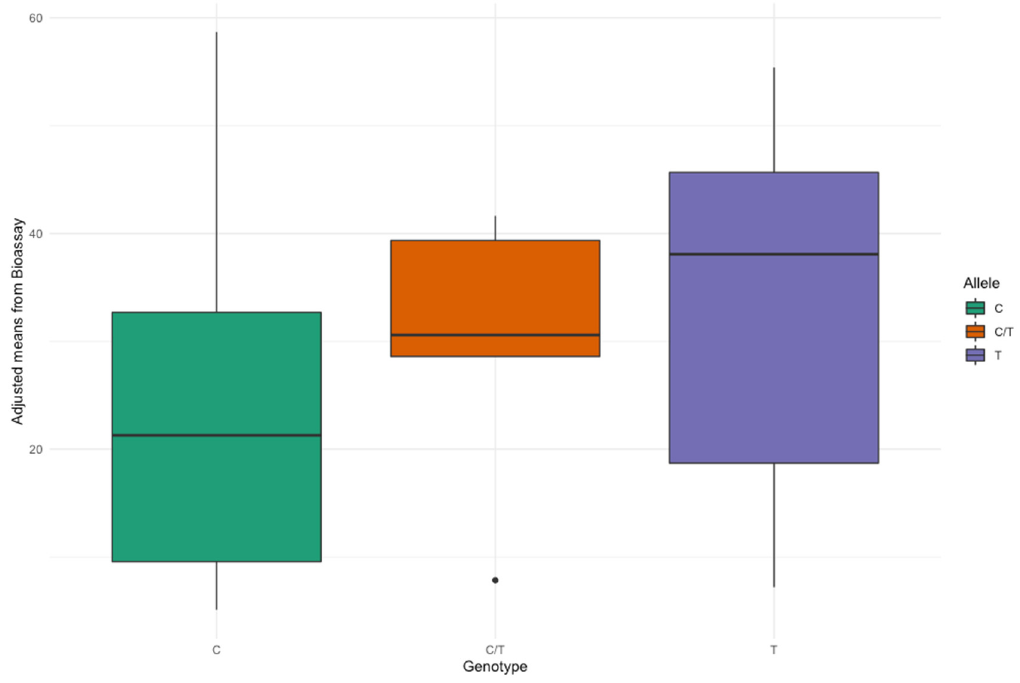
Figure 6. Boxplot between the three marker genotypes of RsBv1 (Chr6, 9000093 bp) and adjusted means obtained from Rhizoctonia bioassay of 62 lines. means obtained from Rhizoctonia bioassay of 62